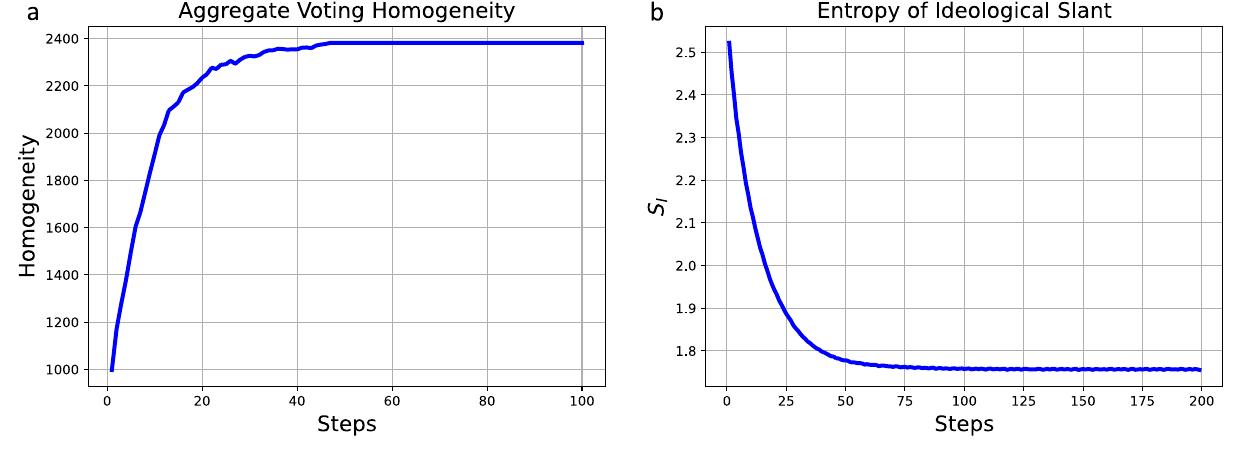
Figure 1. In plot ( a ) the homogeneity of the political choices over the lattice contained in matrix M over time is shown. Plot ( b ) shows the entropy for a political component of a system simulation, S I , t with time steps t . The entropy decreases until it converges with oscillations. N sim = 1000 is the number of independent simulations conducted and the average value presented. The dynamics on the agents’ political affiliations (Eq. 1) causes agents to influence each other from their adjacent positions causing them to eventually coalesce. The coalesced state is at a lower entropy than the initial random allocation of ideological